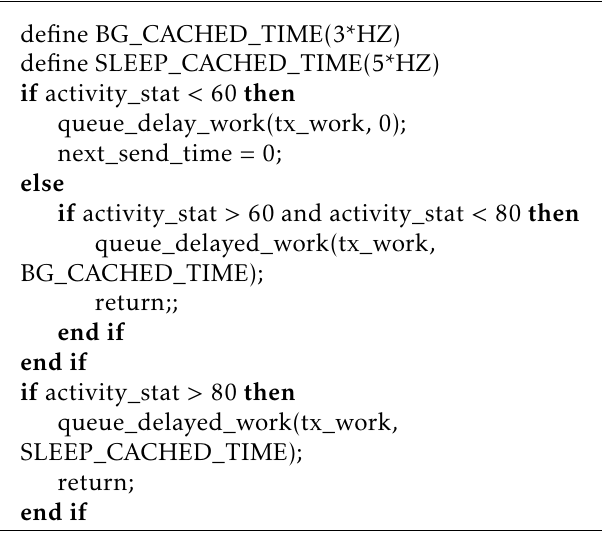
Algorithm 3 when data transfer is